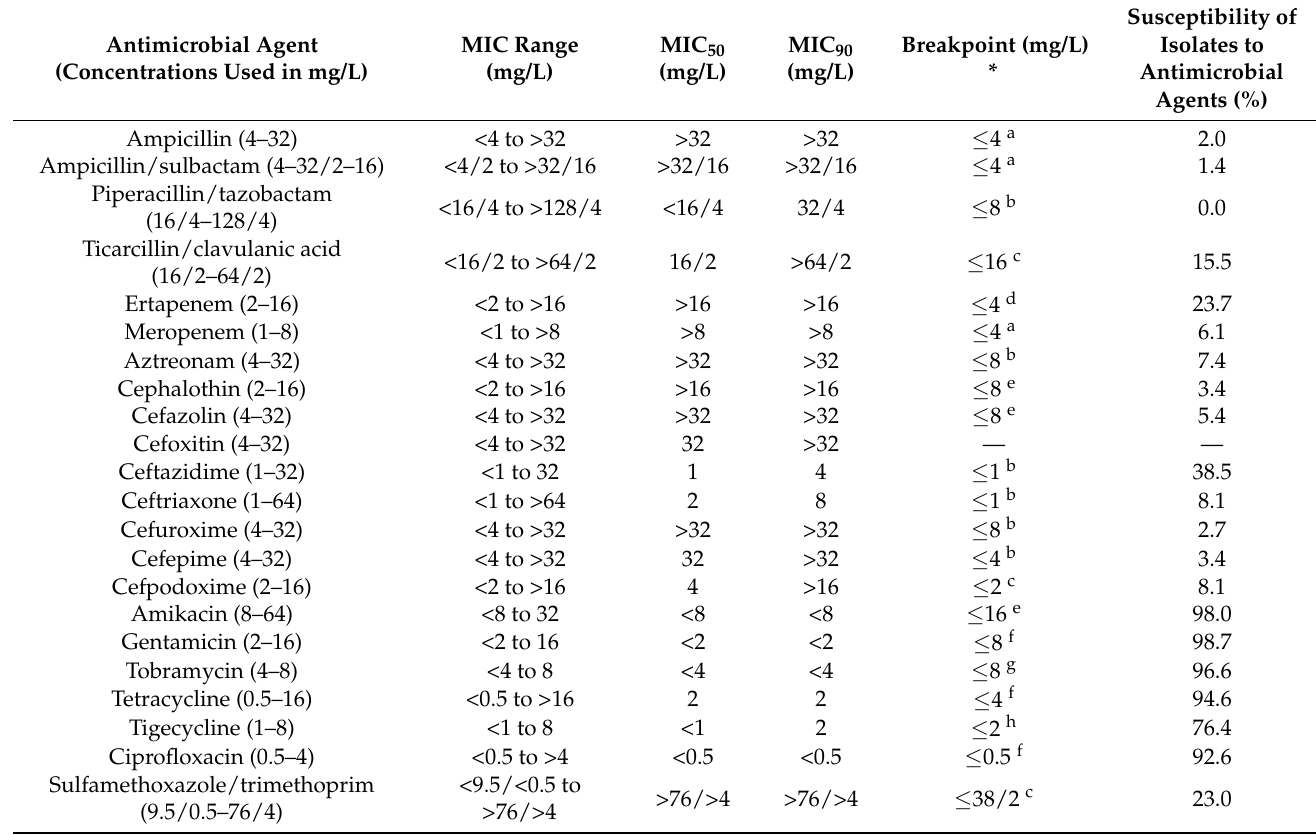
Table 1. Minimum inhibitory concentration (MIC) range, MIC 50 , MIC 90 , and percentage of susceptibility of 148 animal Francisella tularensis subsp. holarctica field isolates to 22 antimicrobial agents.